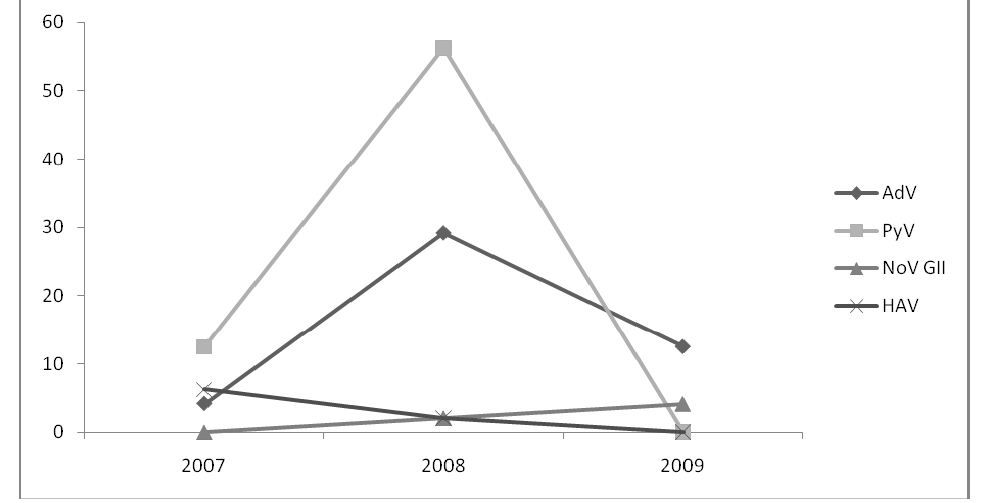
Figure 1. Annual percentage (%) detection of viruses in forty-eight (48) analyzed sewage samples from the inlet of the wastewater treatment plant. AdV: adenoviruses,